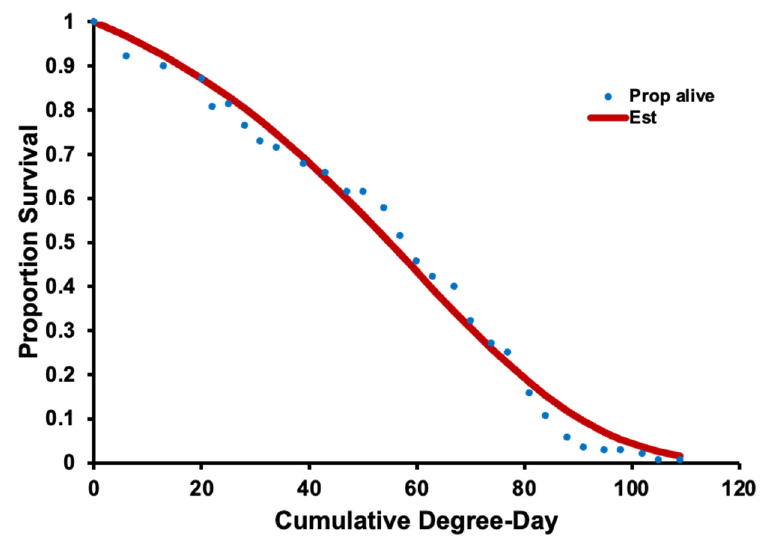
Figure 6. Time-specific survival ( L x , blue dots) and Gompertz distribution fit (red line) of adult H. halys in Oregon at 8 °C and 16:8 D:L light regimes.